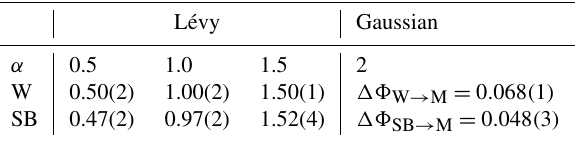
Table 1. Estimates of the exponent α via the fitting of Eq. (B6) for the Lévy case (three first columns) and of the energy barrier (cid:49)(cid:56) W / SB → M via the fitting of Eq. (17) for the Gaussian case (last column). In parenthesis, the estimated error of the last digit is shown. Lévy